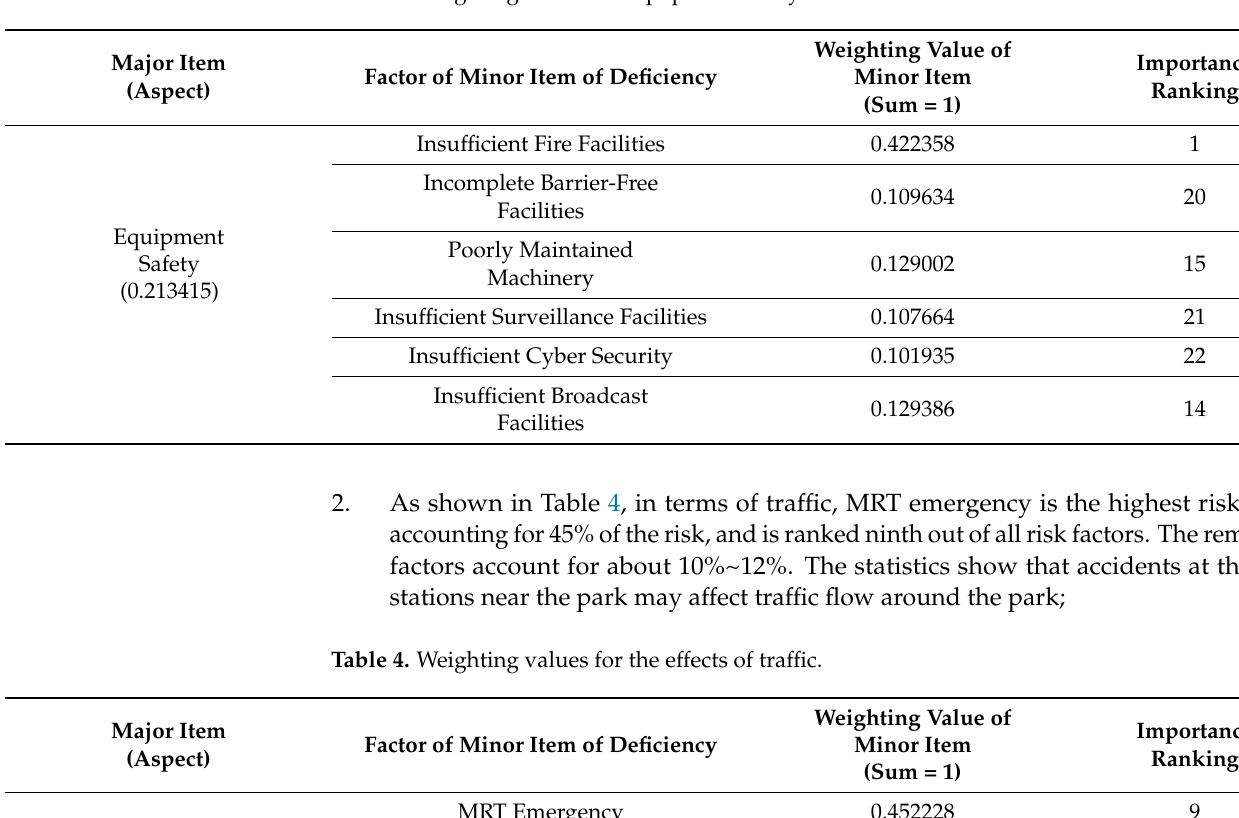
Table 3. Weighting values for equipment safety.